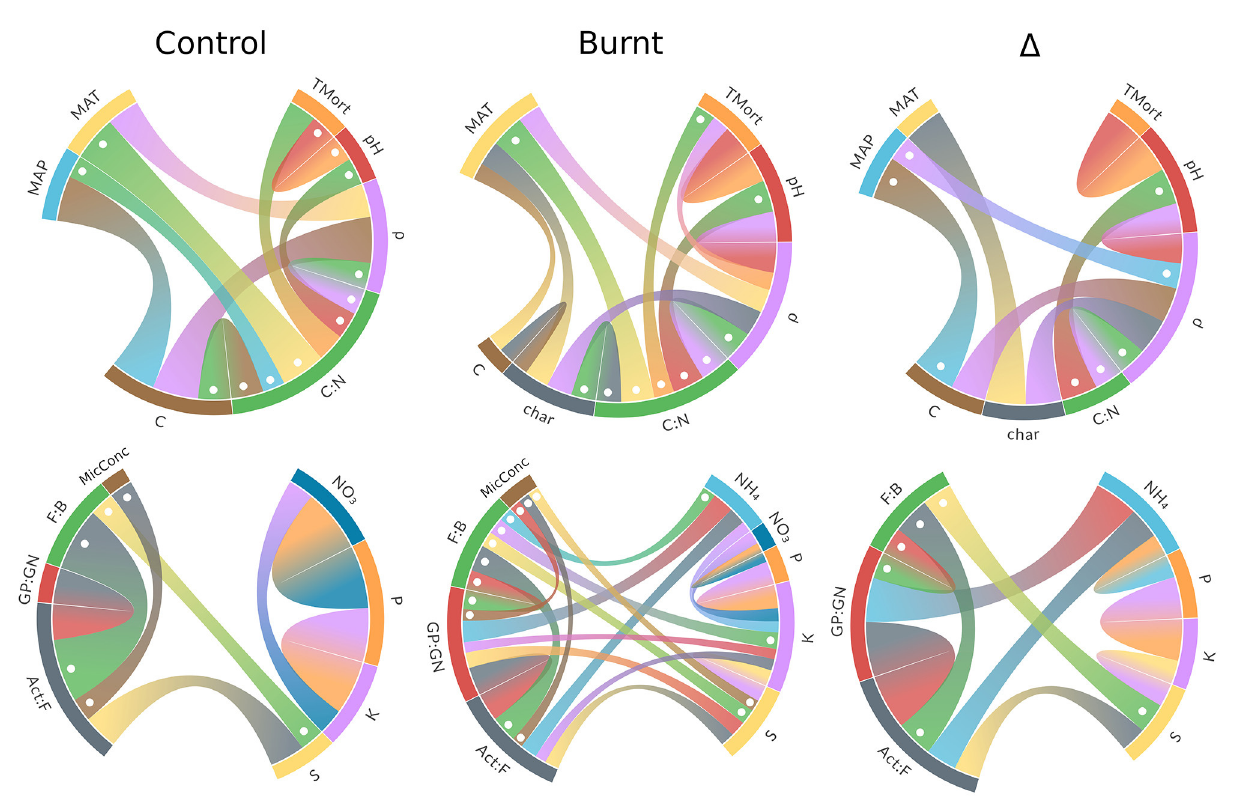
FIGURE3 Chord diagrams of significant ( p < 0.05) bivariate correlations between climate and forest properties (top row) and microbe and nutrient variables (bottom row) . Ribbon thickness is scaled within each diagram (but not across diagrams) to Pearson’s r with negative values dotted. Numerical results for climate and forest property diagrams are found in Supplementary Table S1 and microbe and nutrient variable diagrams in Supplementary Table